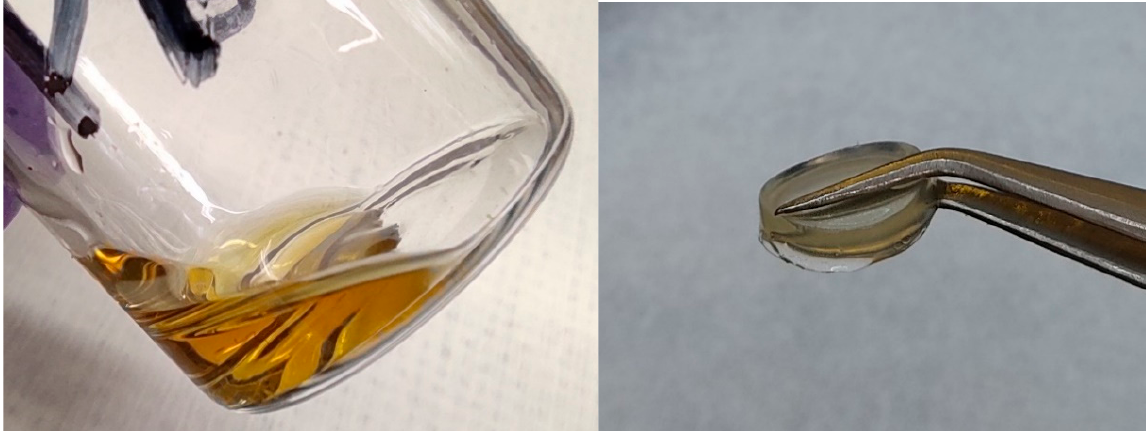
Figure 3. P[C 8 N A,22 ]TFSI polymer mixture with additional 45 wt % MPPyrr-TFSI and without cross-linker ( left ) same P[C 8 N A,22 ]TFSI polymer mixture (PIL_6_7) with additional 2.5 wt % of cross-linker ( right ).